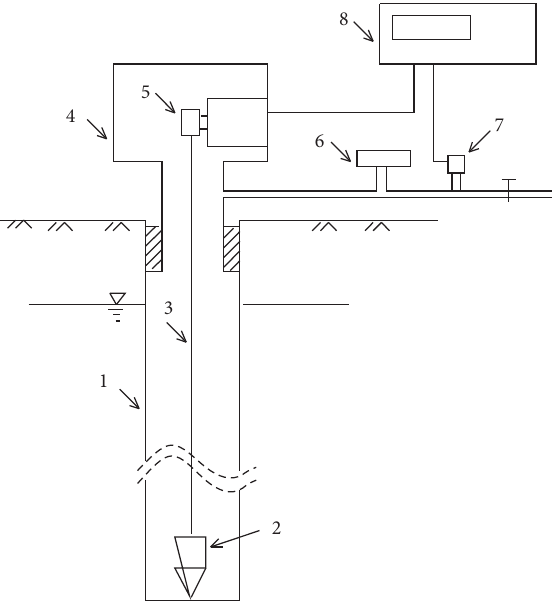
Figure 1: Layout plan of the differential water pressure test scheme. 1- drill hole; 2- turbine current meter; 3- electric cable; 4- sealing device; 5- stepper motor; 6- water supply device; 7- pressure sensor; and 8-